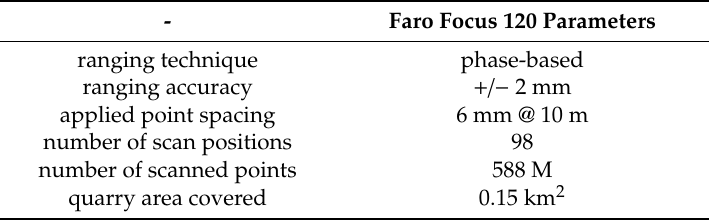
Table 1. Terrestrial laser scanning parameters.